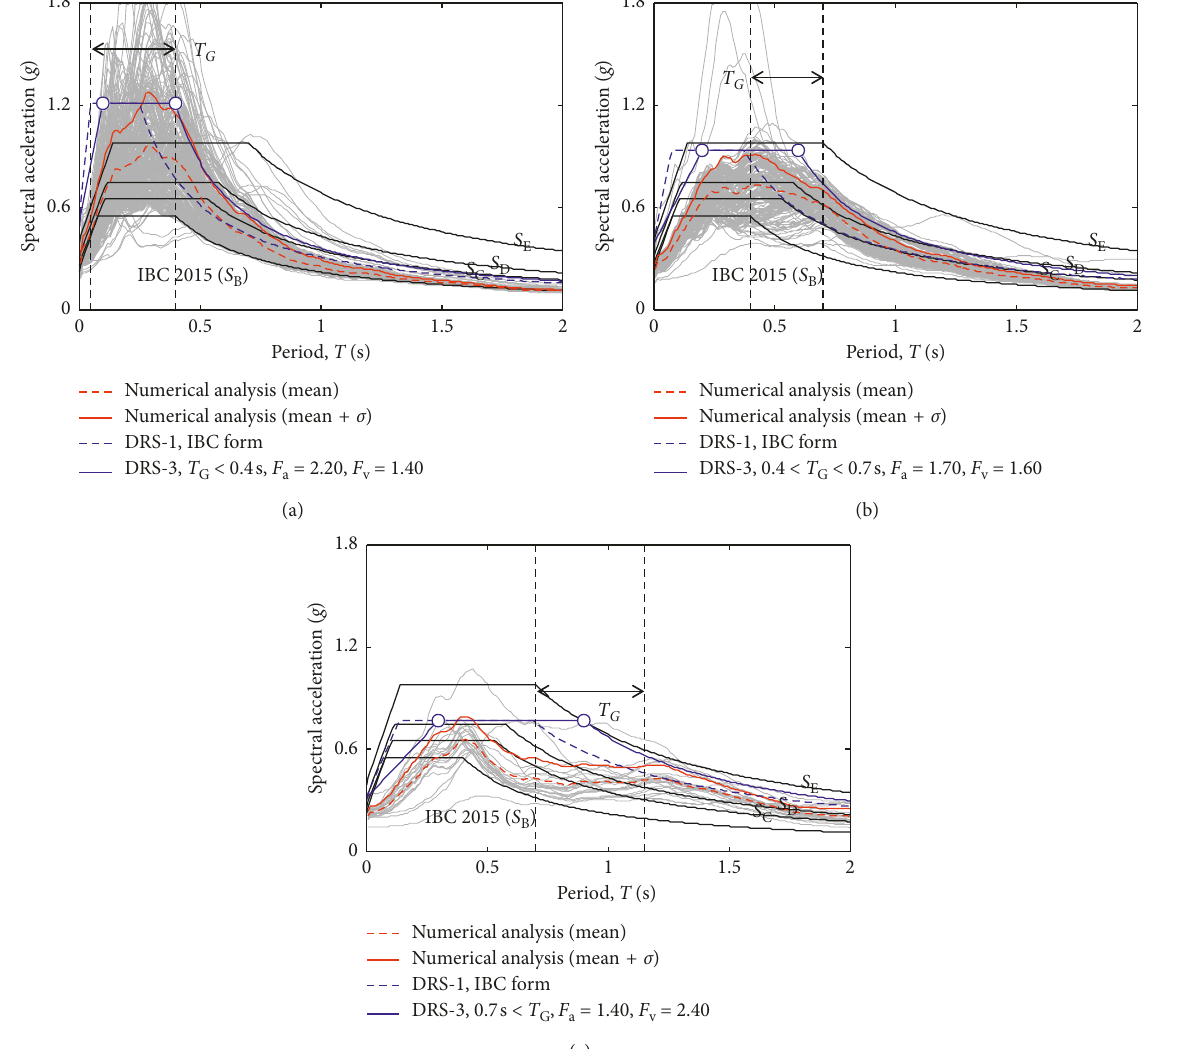
Figure 16: Comparison between numerical analysis results and DRS-3: (a) short-period sites. (b) Midperiod sites. (c) Long-period